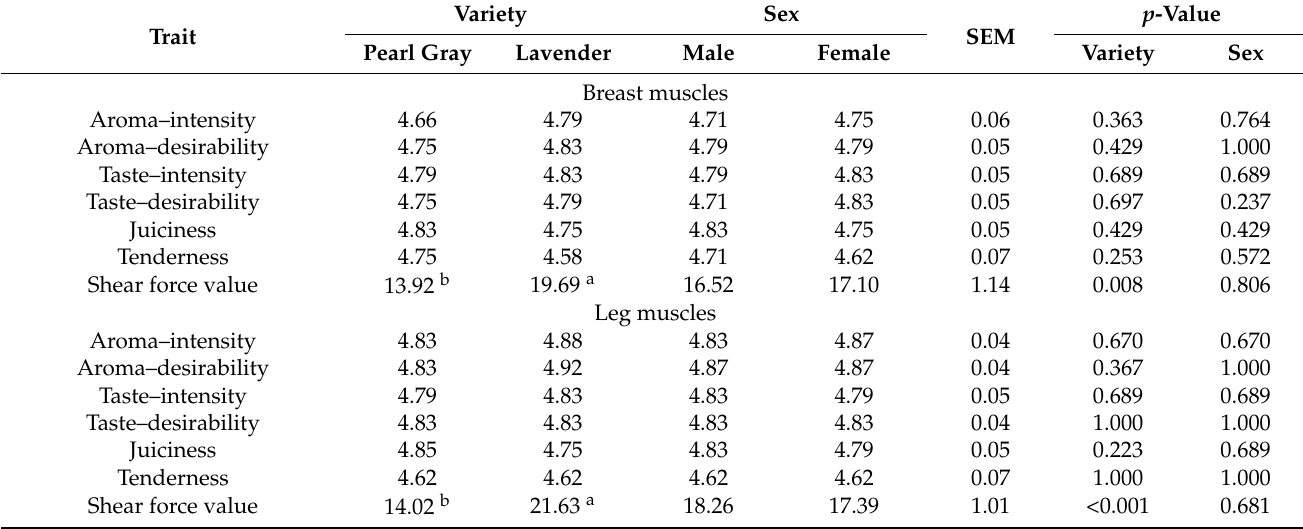
Table 5. Sensory properties (points) and shear force values (N) of breast and leg muscles of male and female guinea fowl of pearl gray and lavender varieties (means ±